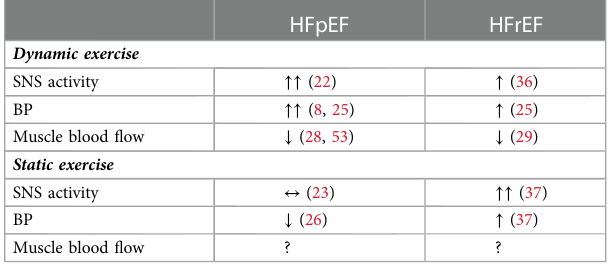
TABLE 2 Summary of sympathetic and hemodynamic responses to dynamic and static exercise in patients with HFpEF vs. HFrEF compared to non-HF